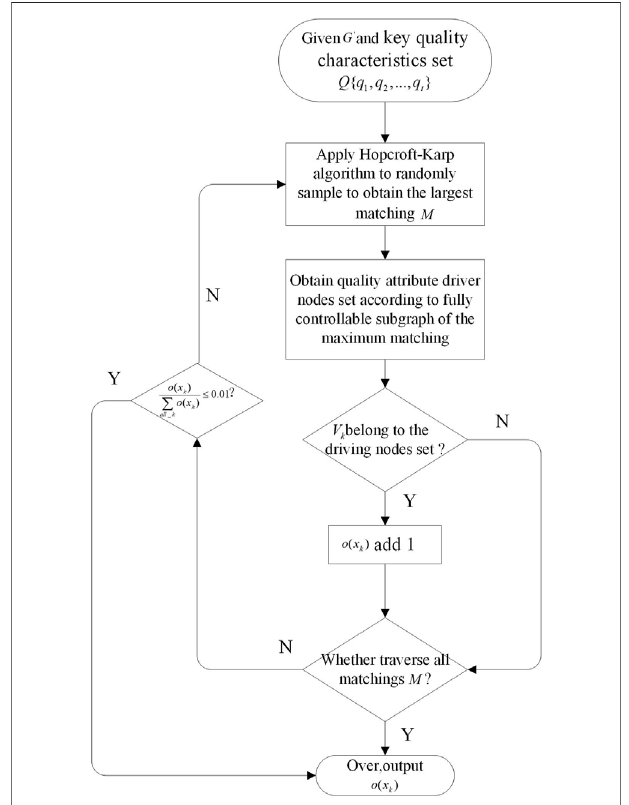
FIGURE 11 | Target node x k control ability quanti fi cation algorithm fl